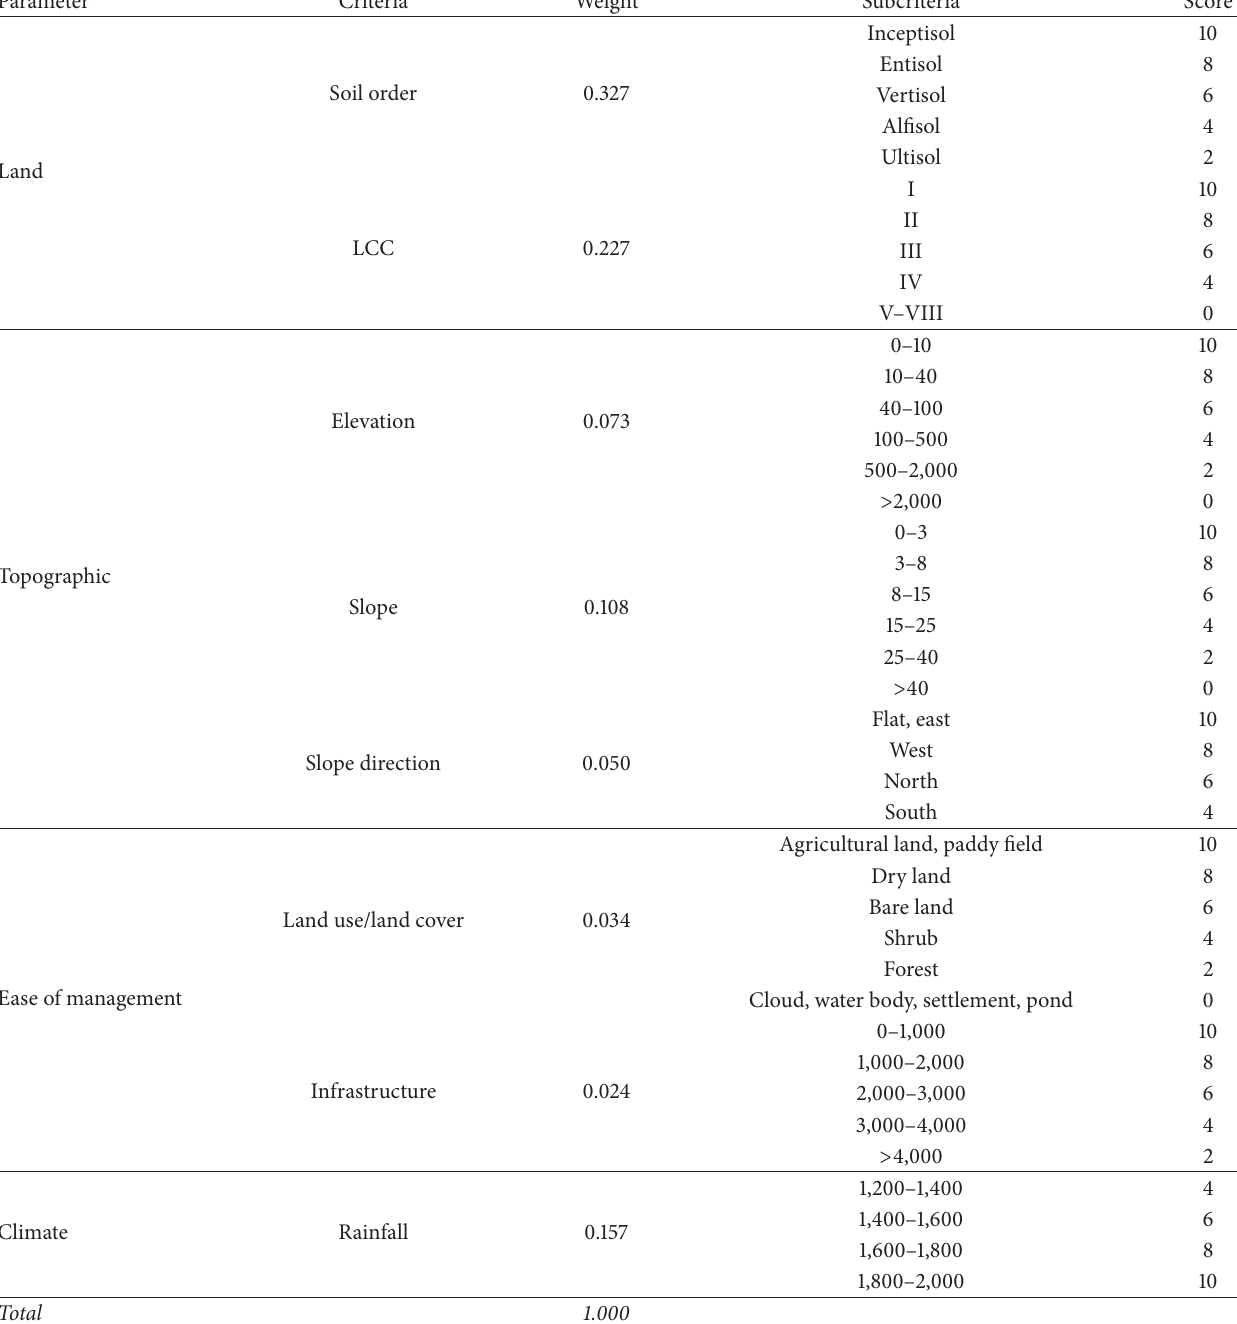
Table 4: Scores of the subcriteria used in Tuban